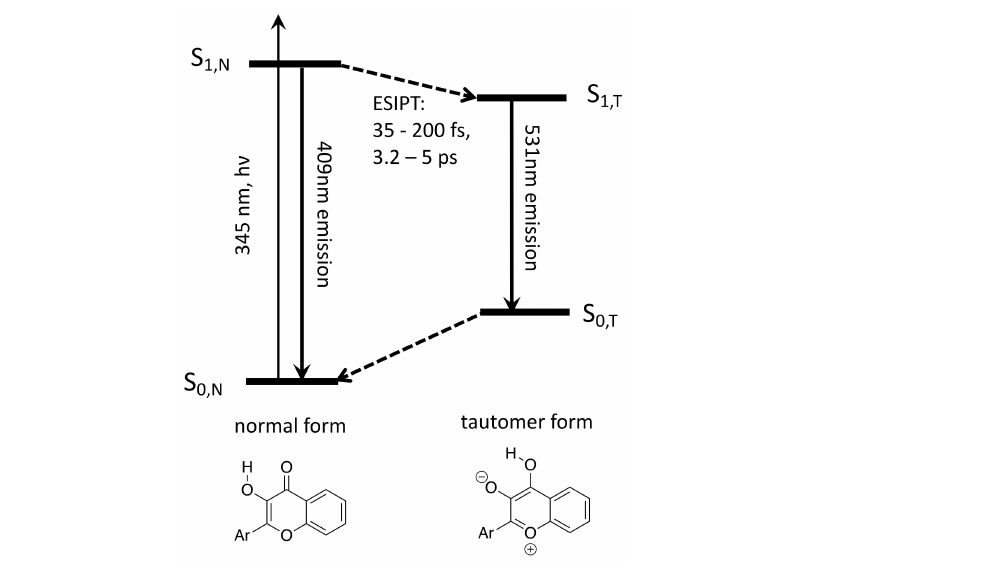
Scheme 1. Photocycle of 3HF with lower energy UV excitation. After initially populating the excited state S 1,N , ESIPT occurs with time constant 35–200 fs and 3.2–5 ps to form the excited tautomer state [16] and decay back to the ground state S 0,T followed by an ultrafast ground state back to normal form S 0,N . Dual fluorescence emission bands were observed from S 1,N and S 1,T.